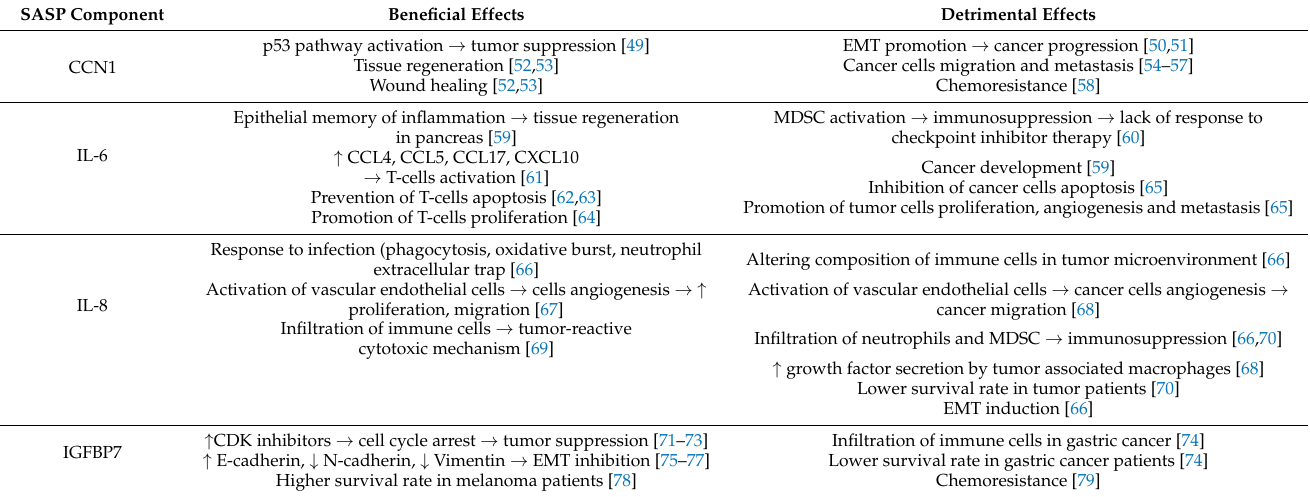
Table 1. Beneficial and detrimental effects of the SASP components: CCN1 (cellular